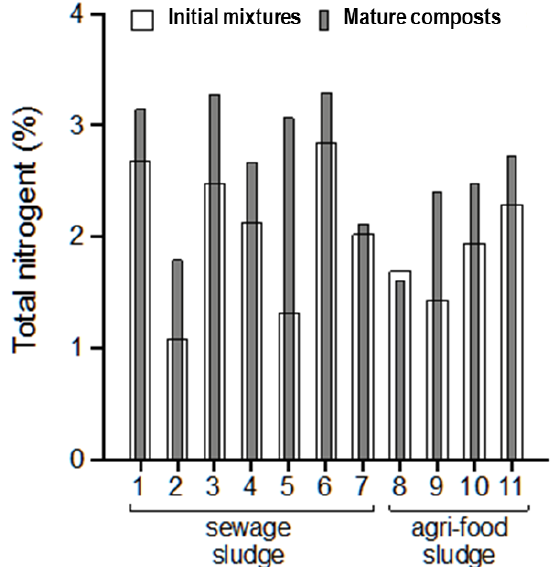
Figure 4. Total nitrogen concentration (%) in the initial composting mixtures and final composts.